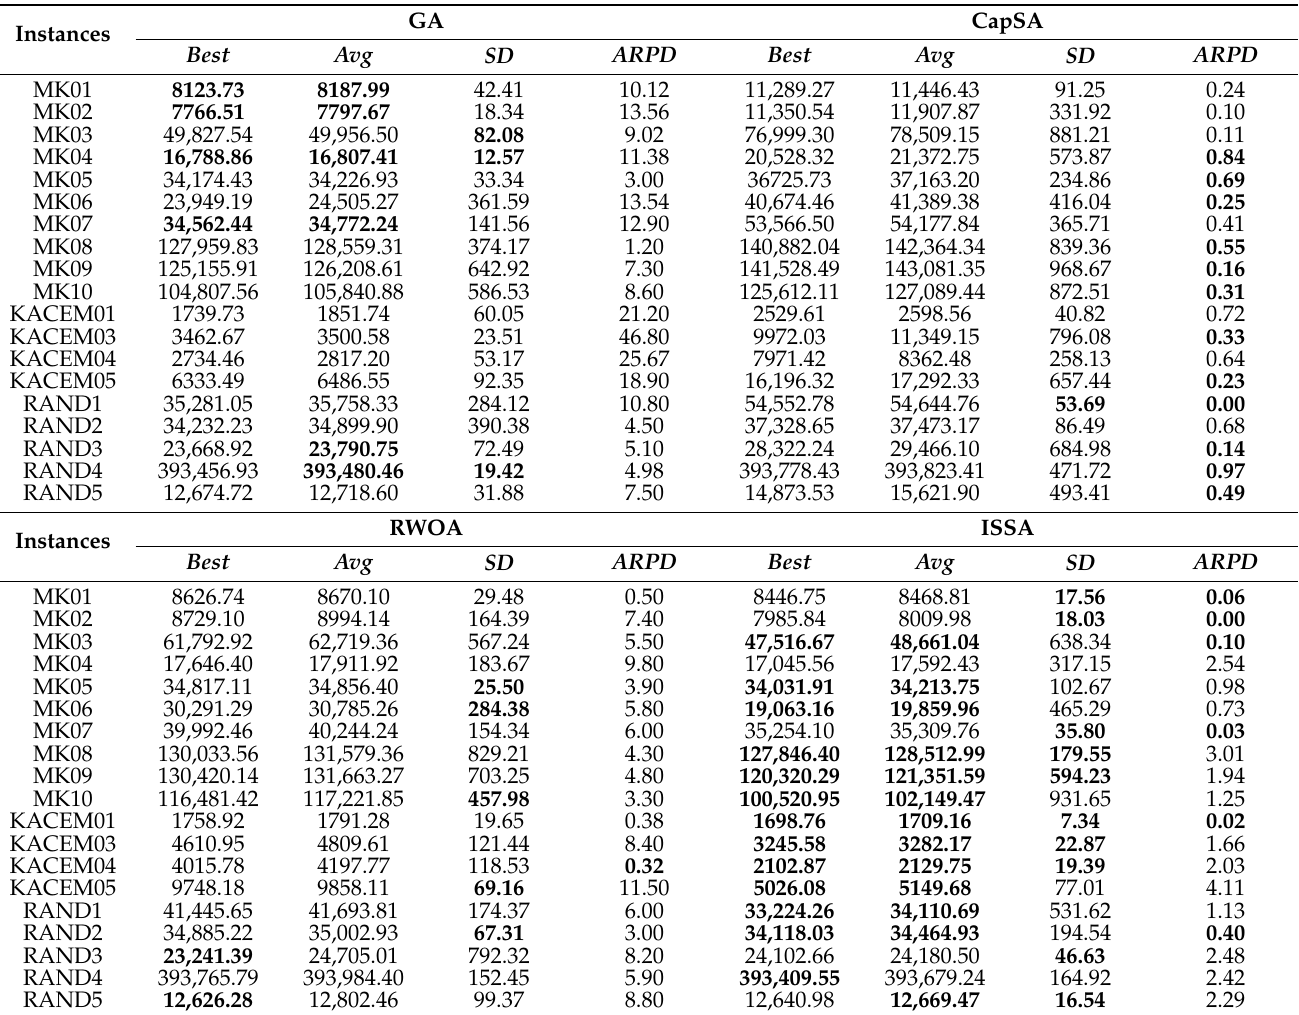
Table 4. Comparative analysis for four different